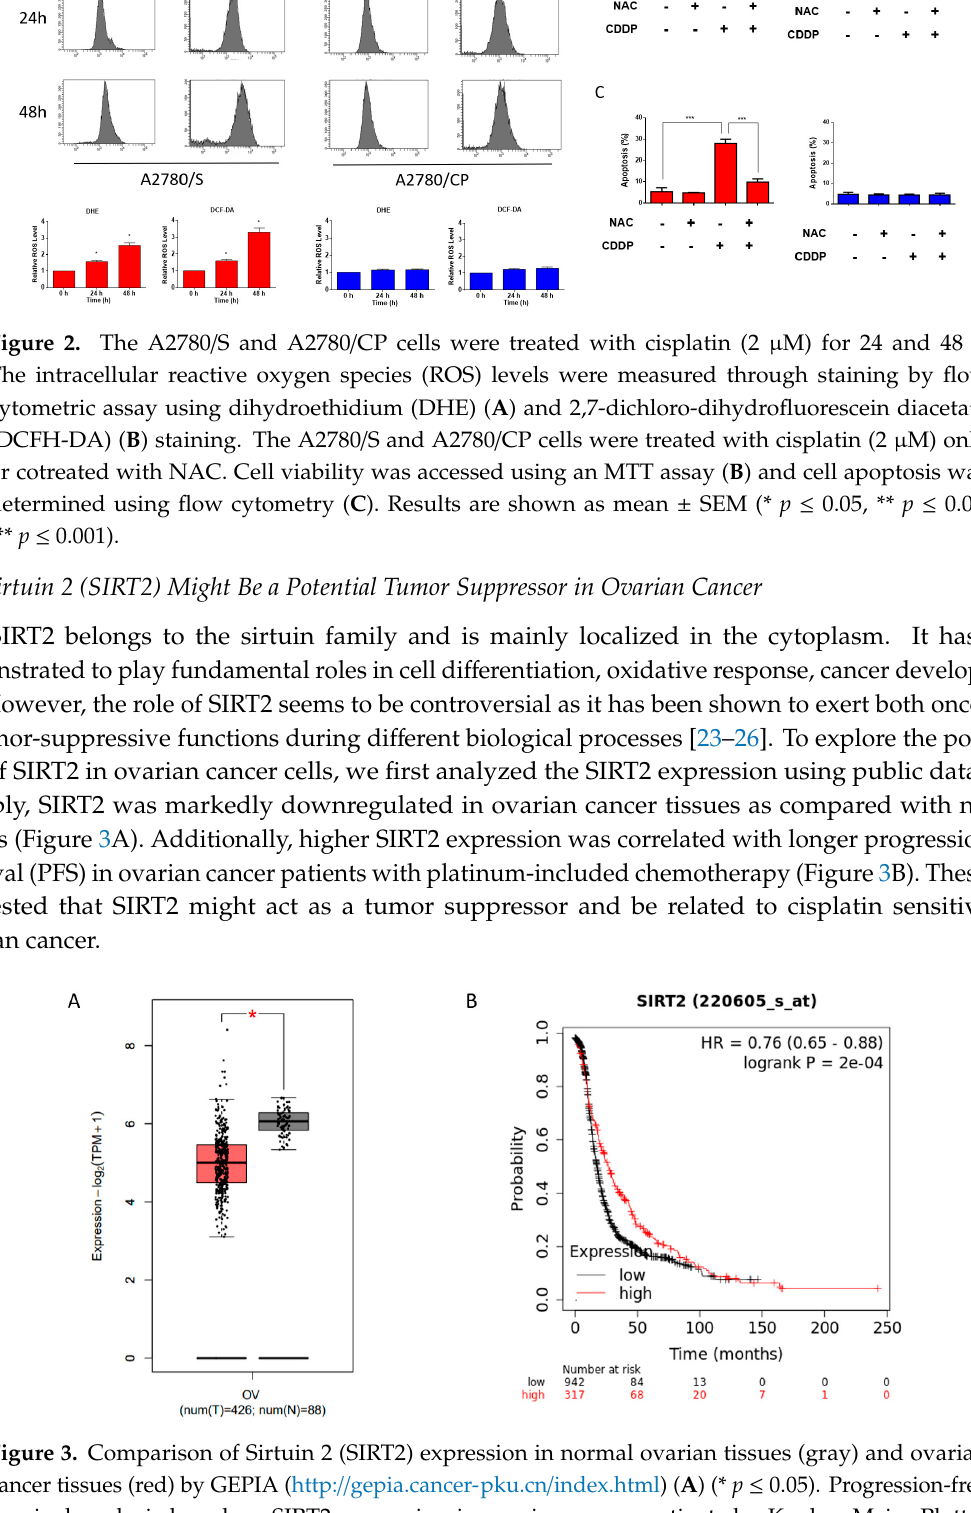
Figure 3. Comparison of Sirtuin 2 (SIRT2) expression in normal ovarian tissues (gray) and ovarian cancer tissues (red) by GEPIA (http: // gepia.cancer-pku.cn / index.html) ( A ) (* p ≤ 0.05). Progression-free survival analysis based on SIRT2 expression in ovarian cancer patients by Kaplan–Meier Plotter (https: // kmplot.com / analysis / ) ( B